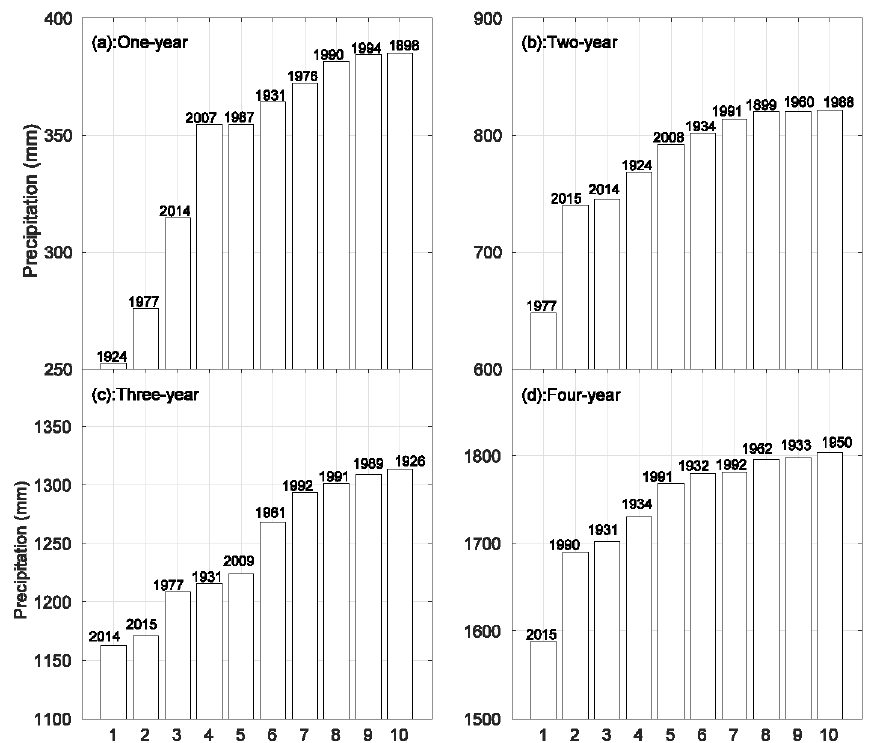
Figure 6. Ten driest ( a ) one-year; ( b ) two-year; ( c ) three-year; and ( d ) four-year periods in terms of statewide (accumulated over study period) precipitation. X -axis shows the ranks with rank 1 indicating the driest conditions. The numbers above bars represent the end year of the corresponding